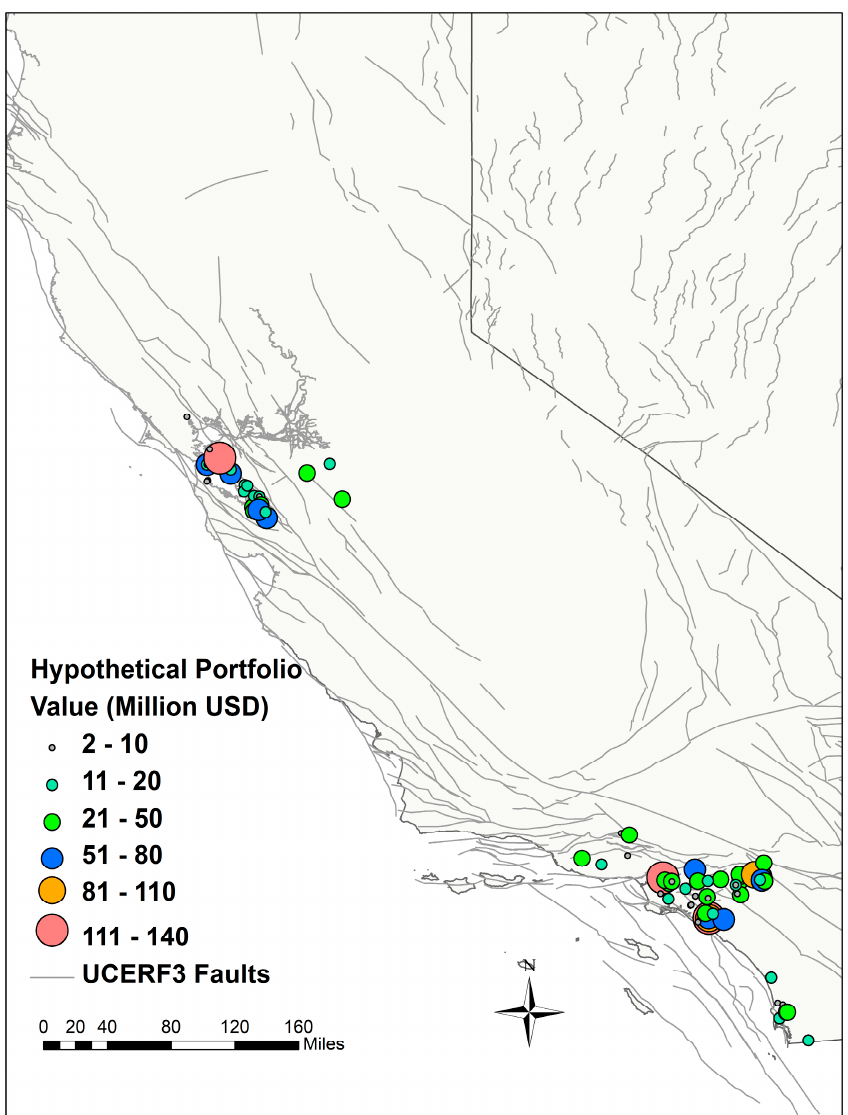
Figure 1. Reproduction of the model 99 building portfolio assess by Lee indicating the location and value of the buildings by the color and size of the filled circle. (Lee et al. 2021). Table 9. Probability that the loss to the model portfolio (P Excd.) exceed the stated values for the Lee et al. 2021 Model Portfolio. The loss simulations were reported to the dollar. No deductibles were considered in the loss calculations.